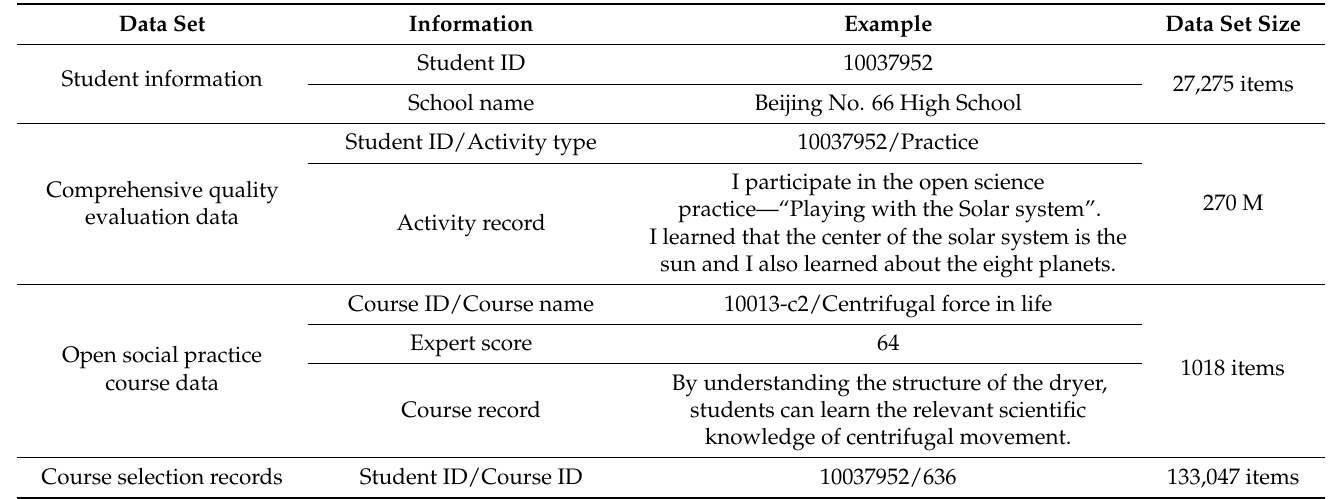
Table 2. Experiment-related data